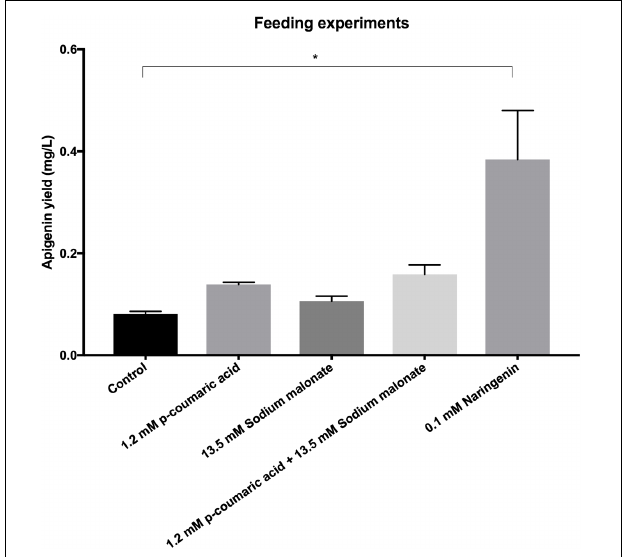
FIGURE 5 | Apigenin production titers in cultures of S. albus- pAPI without feeding (control), and with 1.2 mM p- coumaric acid, 13.5 mM sodium malonate, 1.2 mM p- coumaric acid plus 13.5 mM sodium malonate, or 0.1 mM naringenin final concentrations. Only feeding with naringenin caused a significant 468% increase in apigenin biosynthesis with respect to control conditions. ∗ Statistically significant differences ( p < 0.1) by one-way ANOVA